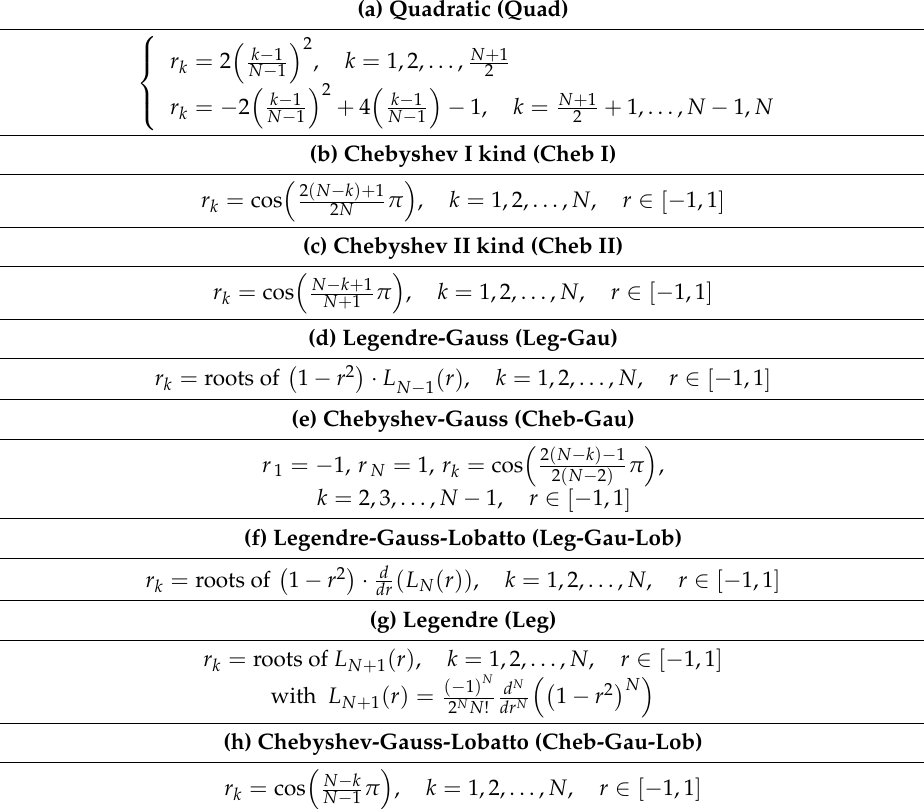
Table 2. Different kinds of discrete grid distributions for the Generalized Differential Quadrature (GDQ) method [130]. Symbols k and N stand for i and I N respectively, along the α 1 direction. On the other hand, k and N specify j and I M respectively, along the α 2 direction. Notations L N , L N + 1 are introduced to denote the corresponding Legendre